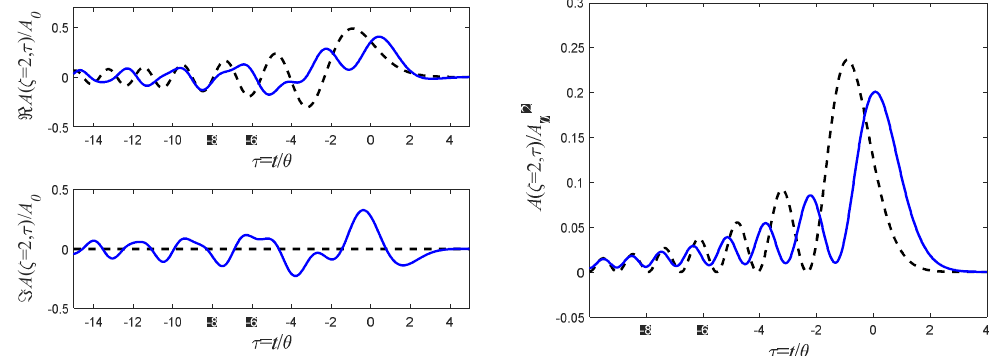
Figure 26. Same as Figure 25, but for Equation (90) with a = 0.1/ θ (for the final distance of ζ = β 2 z / θ 2 = 2/ 2 z ). 2